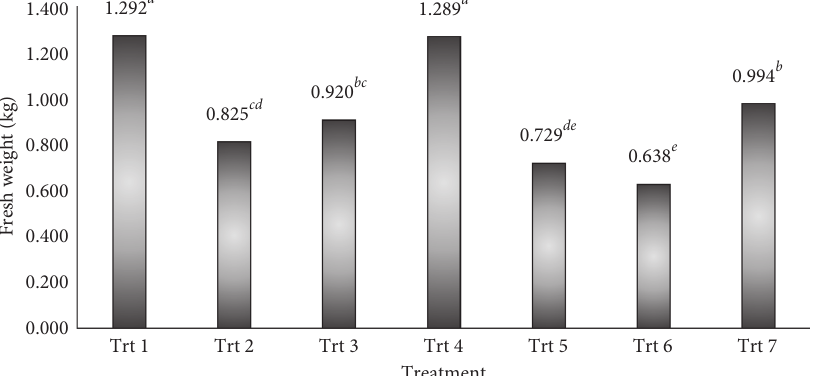
Figure 2: Graph showing yield of mushrooms grown using different substrate combinations.